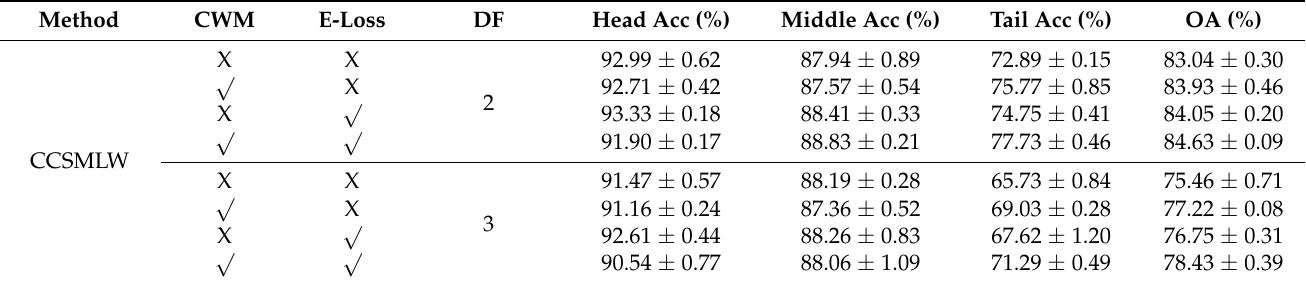
Table 7. Ablation study using long-tailed AID datasets with decay factors of 2 and